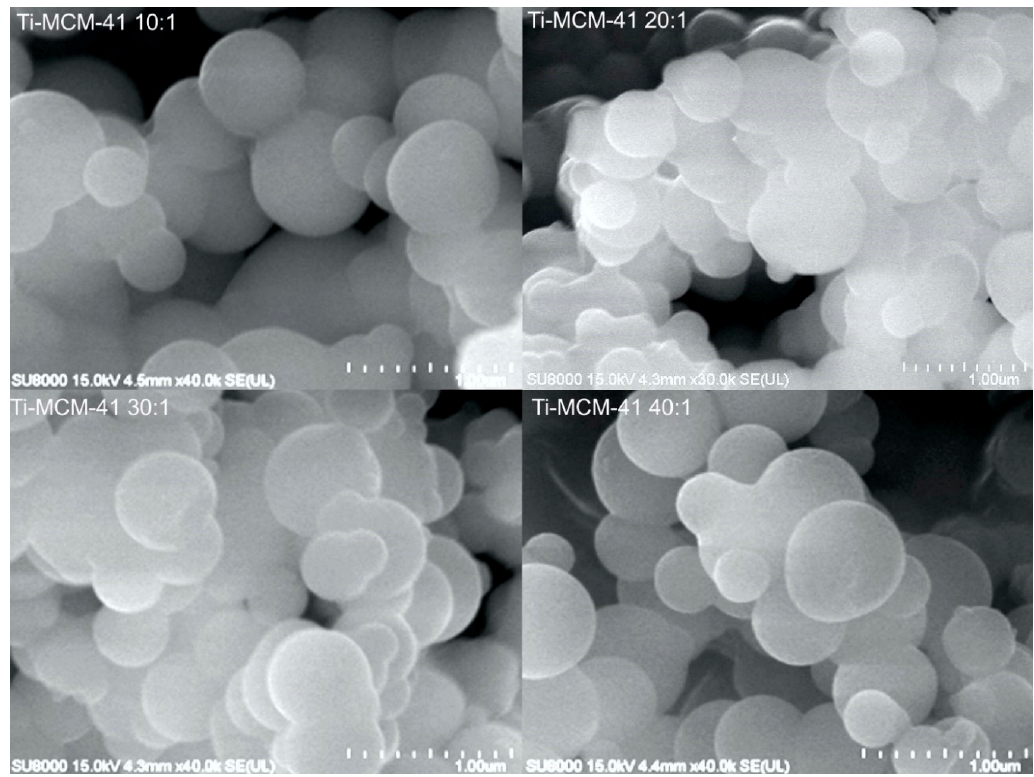
Figure 6. SEM pictures of Ti-MCM-41 catalysts with different molar ratios of Si:Ti in the crystallization gel (respectively, 40:1, 30:1, 20:1, and 10:1).